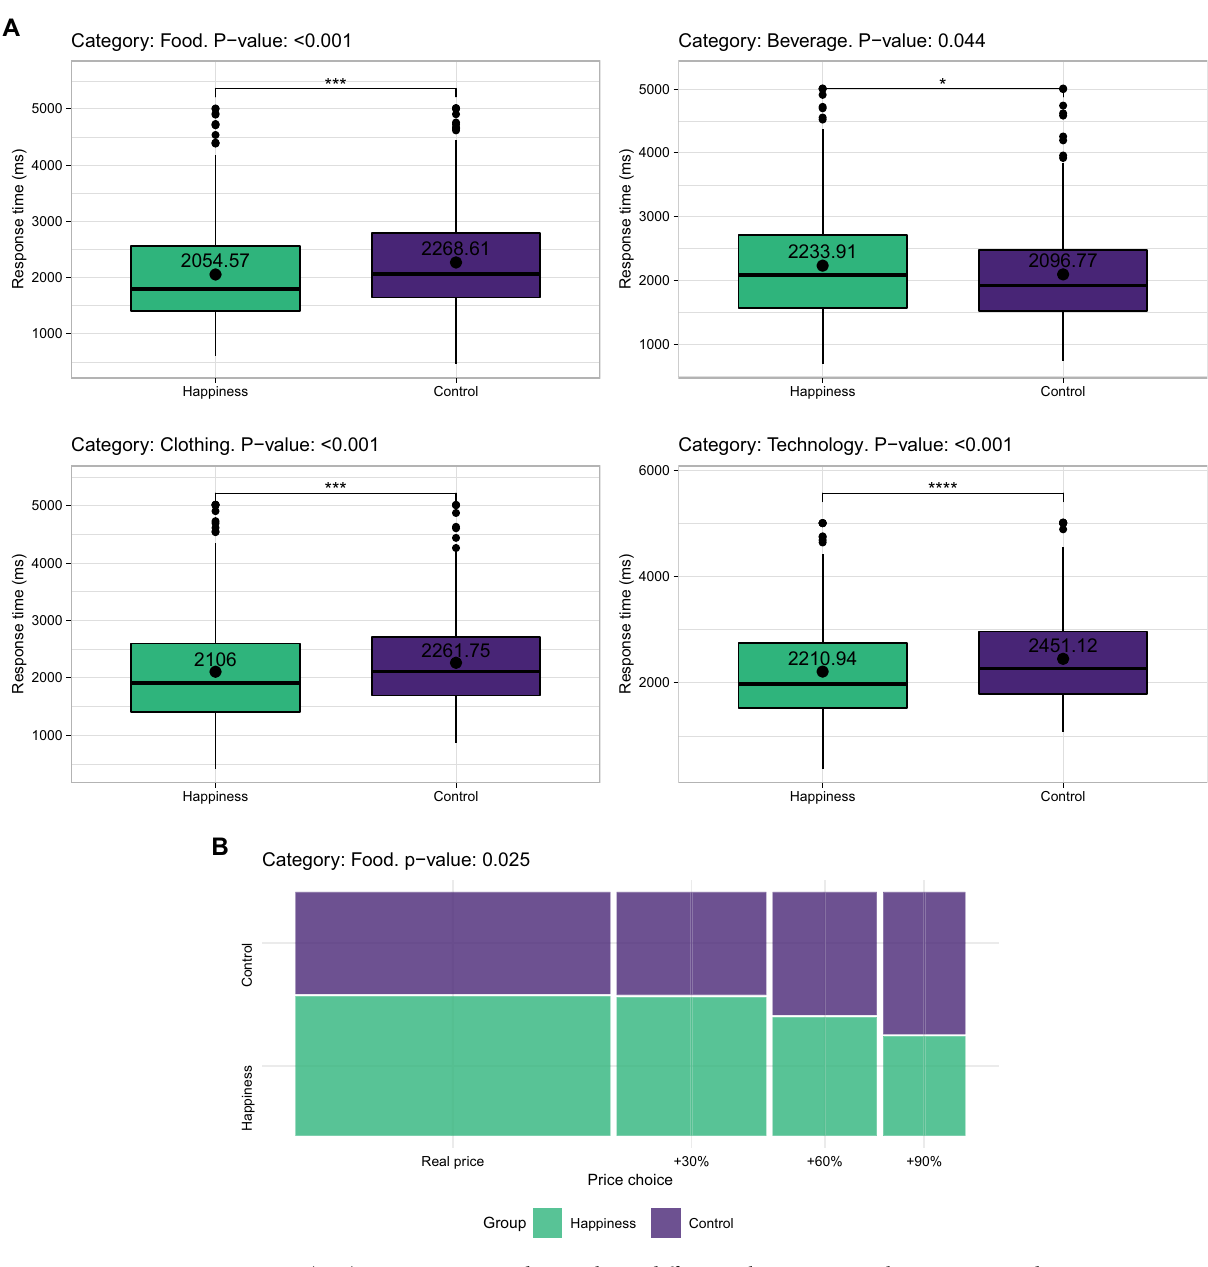
Figure 2. ( A , B ) Response time and price choice differences between control participants and participants exposed to the happiness